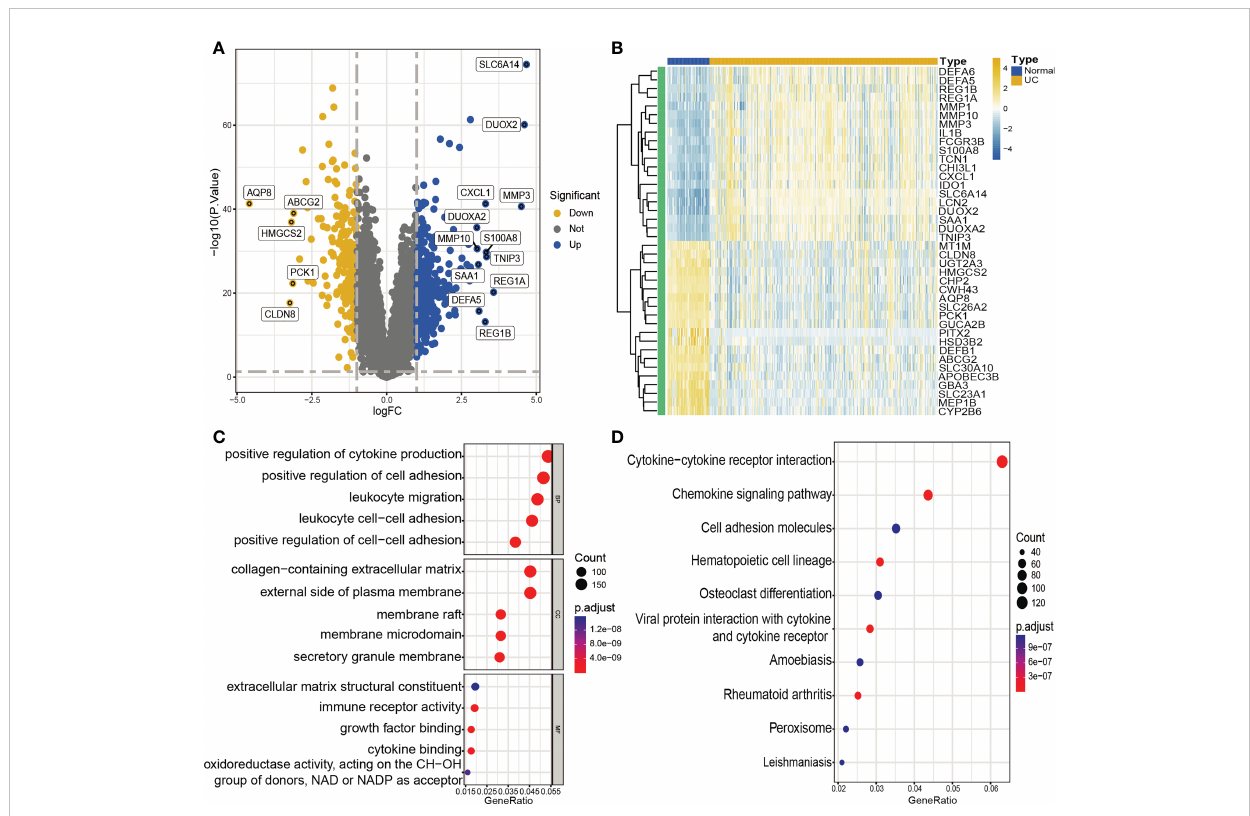
FIGURE 2 Identi fi cation of DEGs and functional annotation. (A, B) . Volcano plot (A) and heatmap (B) showing DEGs between UC and control groups. (A) Blue plot points represent upregulated DEGs, gray plot points represent genes with no signi fi cant difference, and yellow plot points show downregulated DEGs. (B) Each row of the heat map represents one DEG, and each column represents one sample, either UC or normal. (C) GO enrichment analyses of DEGs. BP, biological process; CC, cellular component; MF, molecular function. (D) KEGG enrichment analyses of